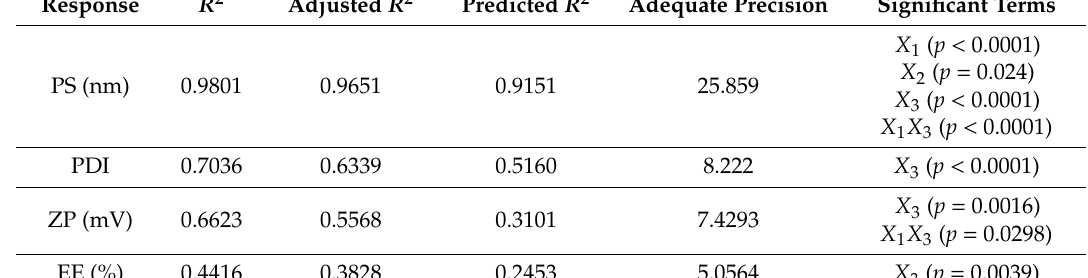
Table 3. Output results of the experimental design.